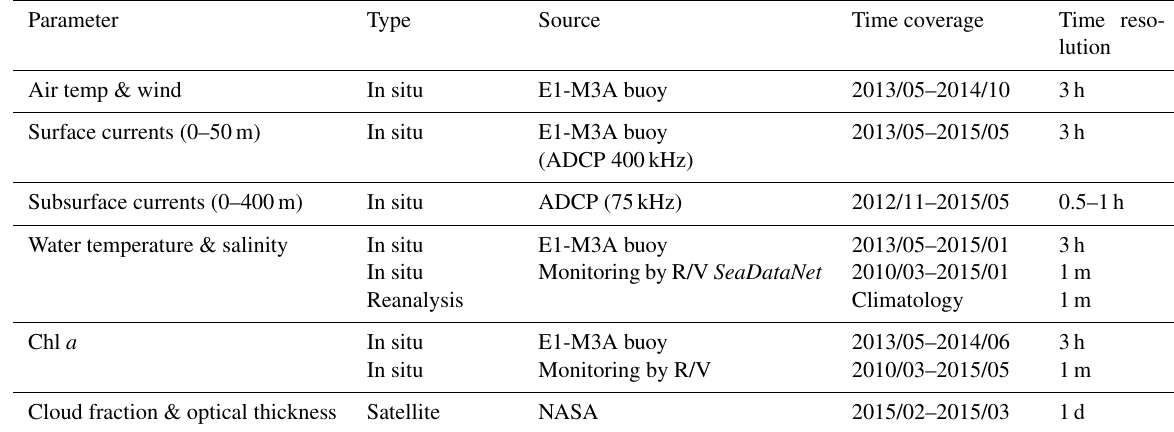
Table 2. The type, source, time coverage and resolution of the auxiliary data. In situ data have gaps of variable lengths. Monitoring by R/V refers to the monthly monitoring program of regular R/V visits to the E1-M3A observatory site. NASA refers to the Goddard Space Flight